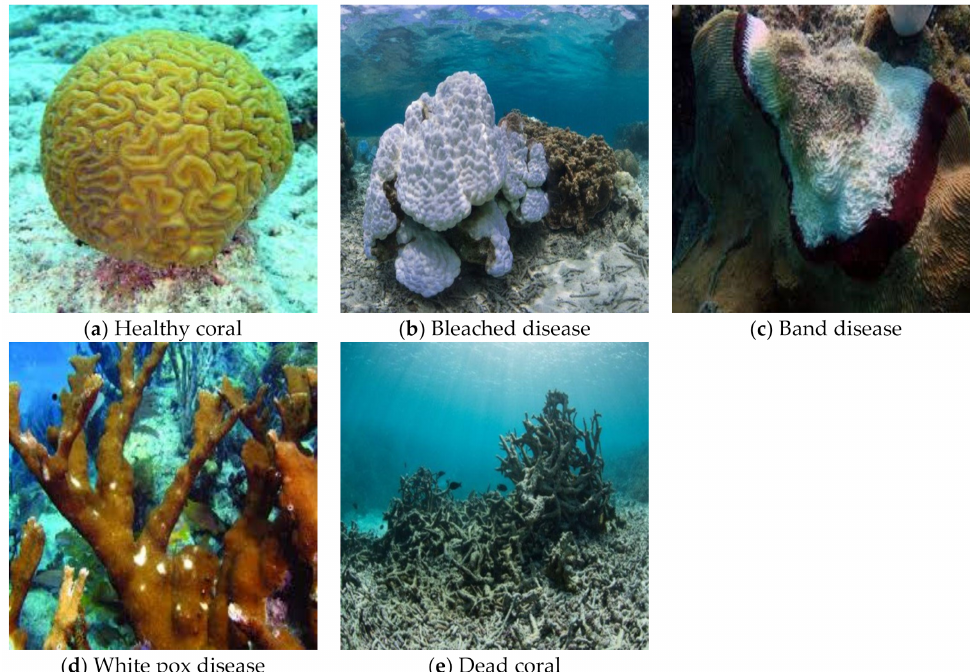
Figure 1. Coral-reef health